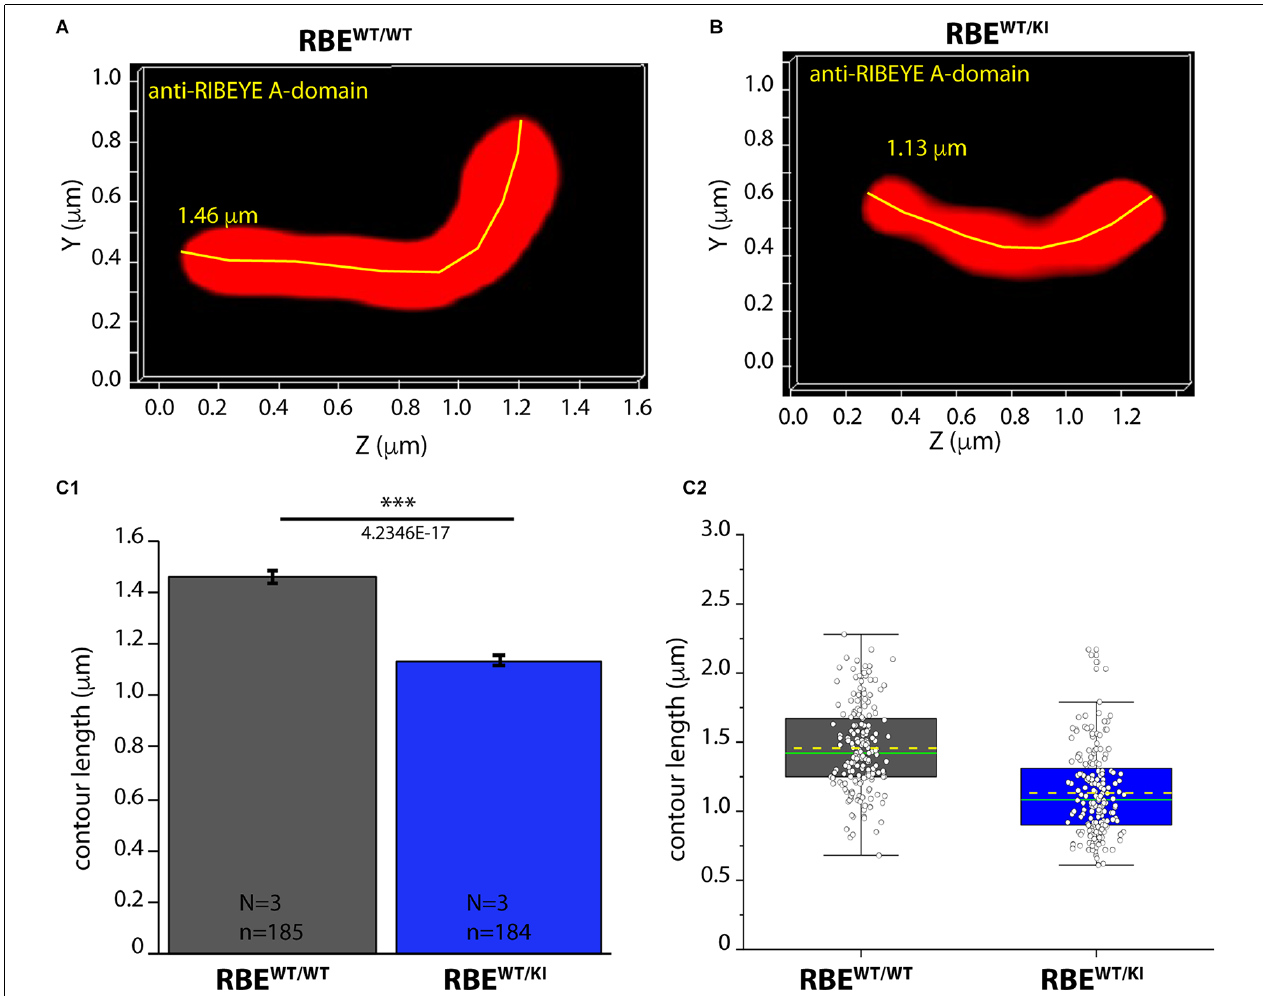
FIGURE 9 | Contour length of synaptic ribbons is reduced in RBE WT/KI mice in comparison to RBE WT/WT mice [3D SR-SIM of ribbons immunolabeled with anti-RIBEYE(A)]. 1.5 µ m-thin retina sections of mice from the indicated genotypes were immunostained with anti-RIBEYE A-domain mouse monoclonal antibody 6F4 and processed for 3D SR-SIM. (A,B) Representative 3D SR-SIM images of individual synaptic ribbons from rod photoreceptor synapses of RBE WT/WT mice and RBE WT/KI mice. The yellow line specifies examples of contour lengths of synaptic ribbons. (C1,C2) Quantitative analyses of the contour lengths of rod photoreceptor synaptic ribbons were measured as maximum 2D projections from the 3D SR-SIM images, as previously described (Dembla et al., 2020; Mukherjee et al., 2020; Kesharwani et al., 2021). Values in (C1) are means ± S.E.M. (1.4569 ± 0.0229 µ m in RBE WT/WT ; 1.1343 ± 0.0227 µ m in RBE WT/KI ). In the box and whisker plot (C2) of the data from (C1) , mean values are indicated by dotted horizontal lines; median values by solid horizontal lines. Boxes represent the 25th-75th percentiles of data points and whiskers are equal to 1.5 times of the interquartile range (IQR). Kolmogorov-Smirnov tests used to determine the statistical significance. Abbreviations: RBE, RIBEYE; S.E.M., standard error of the mean; N = number of mice; n = number of analyzed images; ∗∗∗ p ≤